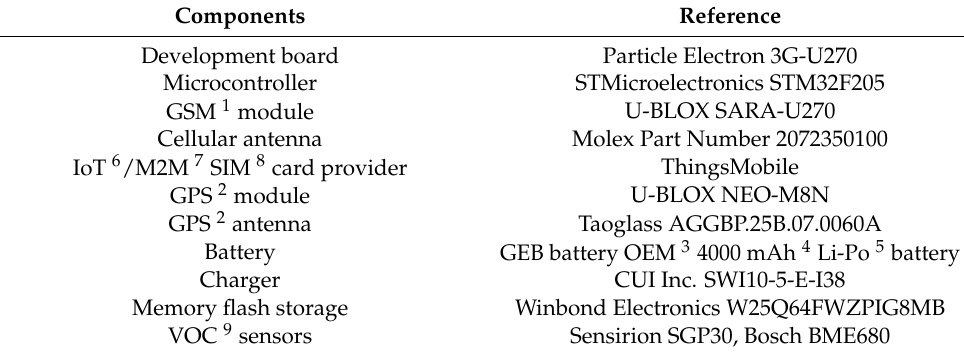
Table 1. Canarin Nano